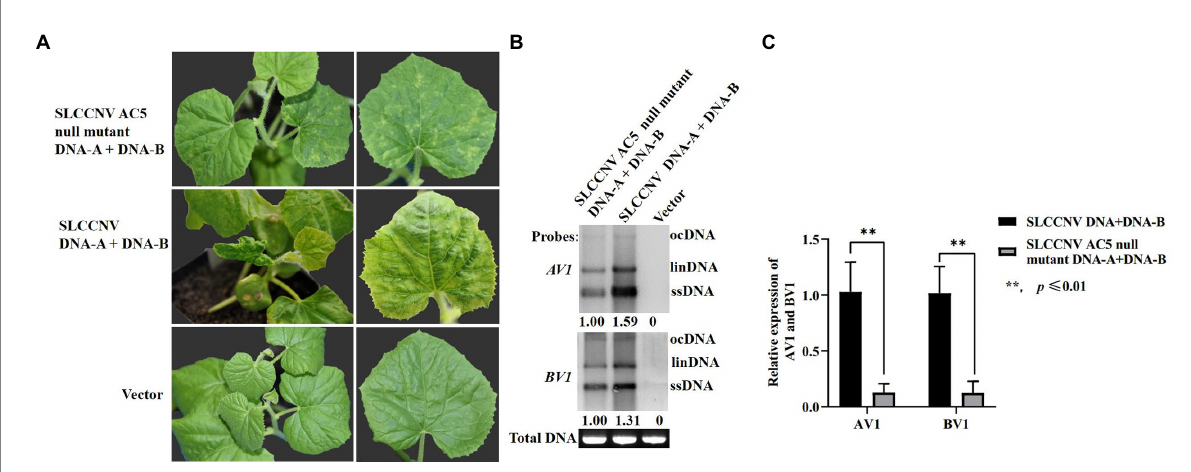
FIGURE 8 Symptoms of melon plants infected with SLCCNV and SLCCNV-AC5 null mutants. (A) Chlorotic mosaic symptoms of melon plants infected with SLCCNV-AC5 null mutant and DNA-B infectious clones (SLCCNV AC5 null mutant DNA-A + DNA-B). Curling and chlorotic mosaic symptoms were observed in melon plants infected with SLCCNV DNA-A and DNA-B wild-type infectious clones (SLCCNV DNA + DNA-B). No symptoms were observed in plants inoculated with an empty vector (negative control). (B) Southern blot analysis of viral accumulation. Leaves inoculated with SLCCNV AC5 null mutant DNA-A + DNA-B, and SLCCNV wild-type were detected at 14 dpi using DNA-A AV1 and DNA-B BV1 genes as probes. The empty vector served as the negative control. Viral open circular (ocDNA), linear (linDNA), and single-stranded DNAs (ssDNA) are indicated. ImageJ software was used to analyze the relative ssDNA expression of DNA-A AV1 and DNA-B BV1 in infected melon plants. (C) Viral DNA accumulation in the SLCCNV-AC5 null mutant DNA-A + DNA-B infected plants and the SLCCNV wild-type DNA-A + DNA-B infected melon plants was detected through quantitative PCR (qPCR). ** p ≤ 0.01, Student’s t